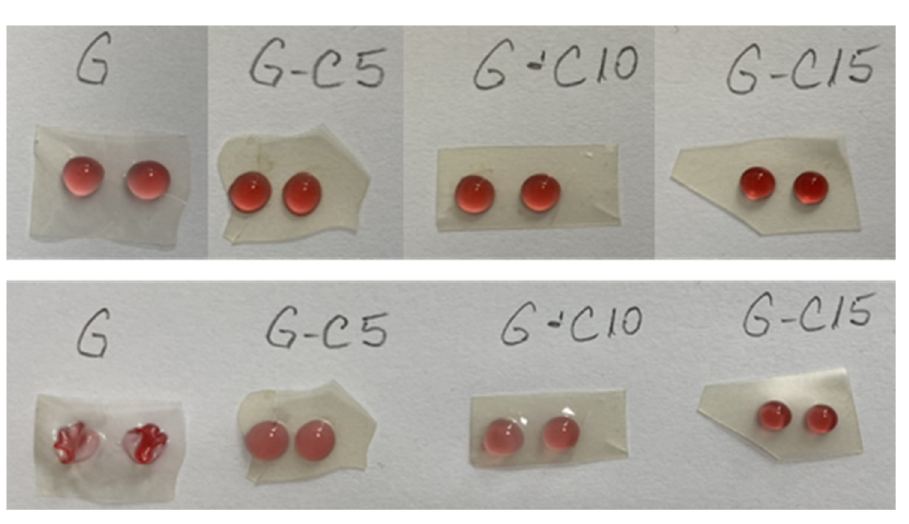
Figure 10. The water droplets on the surface of the films.